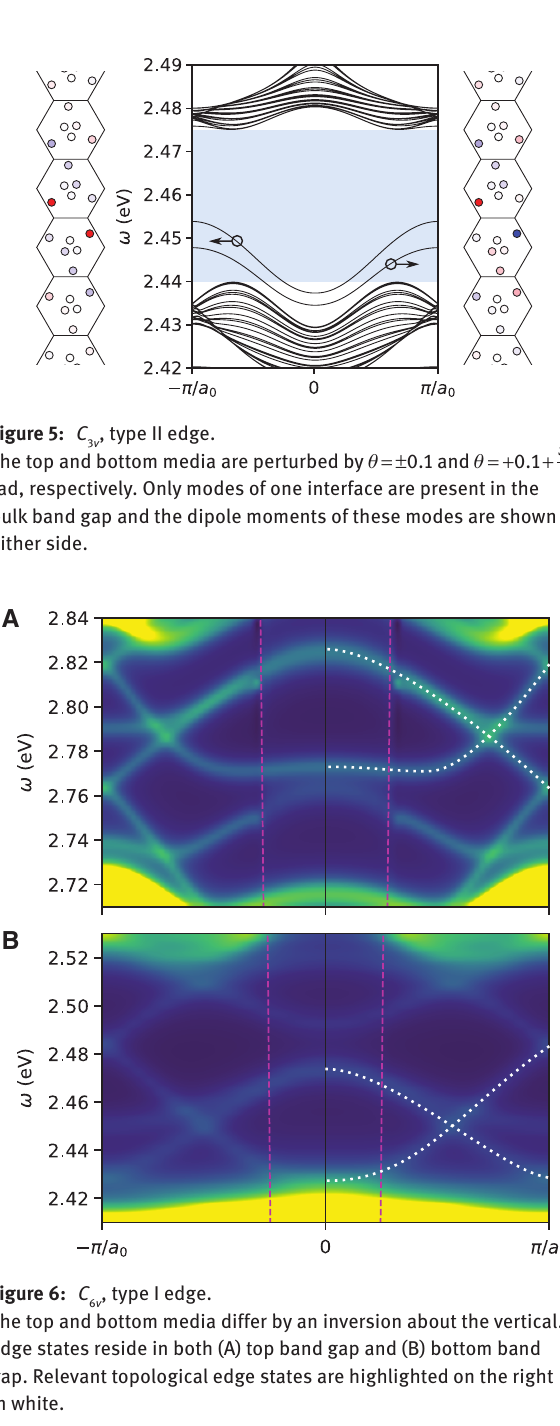
, type I edge. Figure 6: C 6 v The top and bottom media differ by an inversion about the vertical. Edge states reside in both (A) top band gap and (B) bottom band gap. Relevant topological edge states are highlighted on the right in